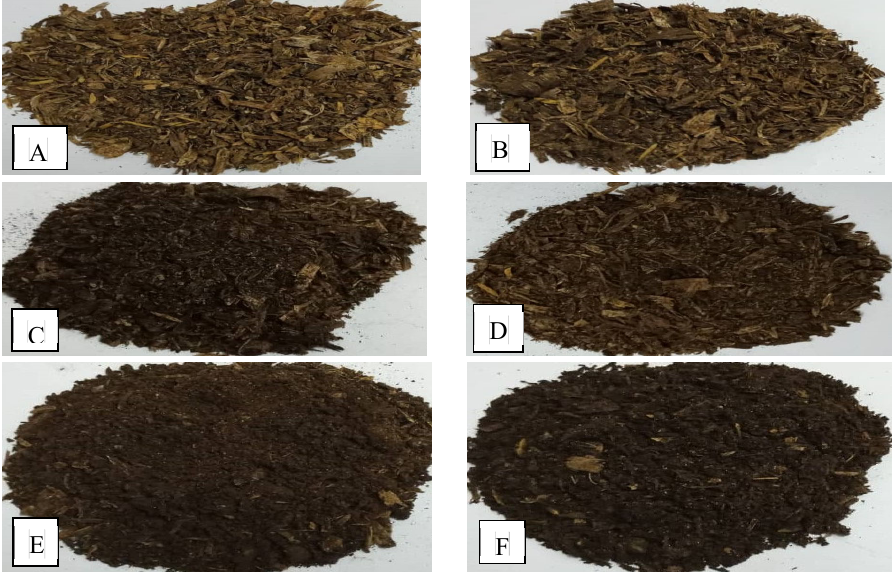
Figure 4. Color and texture of different bokashi fertilizer ratios treated with EM4 after 30 days of maturation. ( A ) bfr1 (80% HBW:0% CD:20% PHC); ( B ) bfr2 (80% HBW:10% CD:10% PHC); ( C ) bfr3 (70% HBW: 20% CD: 10% PHC); ( D ) bfr4 (70% HBW:10% CD:20% PHC); ( E ) bfr5 (60% HBW:20% CD:20% PHC); ( F ) bfr6 (60% HBW:25% CD:15% PHC). Table 2. Main and interaction effects of bokashi fertilizer ratios and time of bokashi fertilizer matura- tion on pH, EC, and CEC.